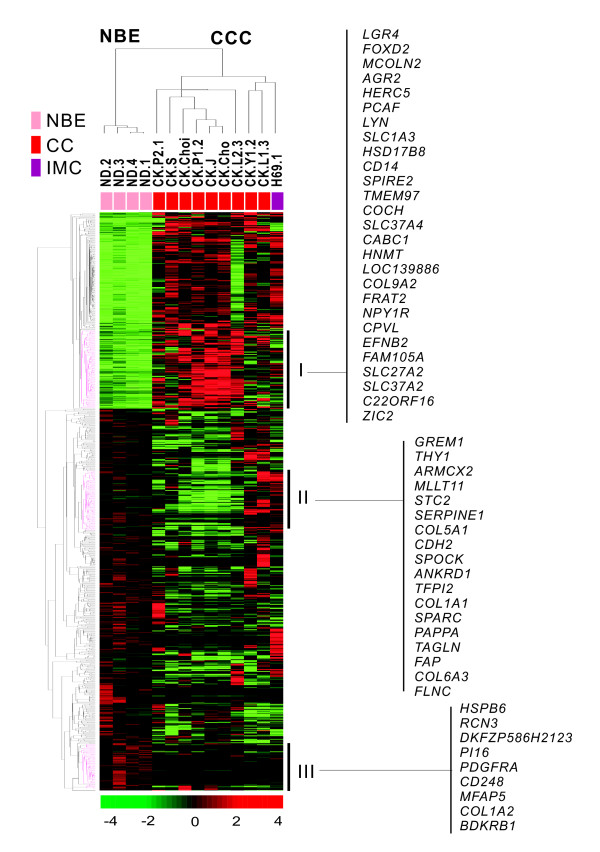
Unsupervised hierarchical clustering of four biliary epithelial cells, one immortalized cholangiocyte cell line and nine CC cells. Unsupervised hierarchical clustering separated the samples into two main groups, normal biliary epithelial cells (NBE) isolated from mucosal slices of normal bile ducts and ex-vivo cultured as described in Methods, and cholangiocarcinoma cells (CCC). Data are in matrix format, with columns representing individual cell lines and rows representing each gene. Red, high expression; green, low expression; black, no significant change in expression level between the mean and sample. A hierarchical clustering algorithm was applied to all cells and genes using the 1 - Pearson correlation coefficient as a similarity measure. Raw data for a single array were summarized using Illumina BeadStudio v3.0 and output to the user was as a set of 43,148 values for each individual hybridization. We selected 828 unique genes with a two-fold or greater difference from the mean and P < 0.01 by t-test, for hierarchical clustering analysis. Specific gene clusters (Cluster 1 through Cluster III) were identified in the hierarchical cluster of the genes differentially expressed in CCC compared with NBE. CC, cholangiocarcinoma; IMC, immortalized cholangiocytes.